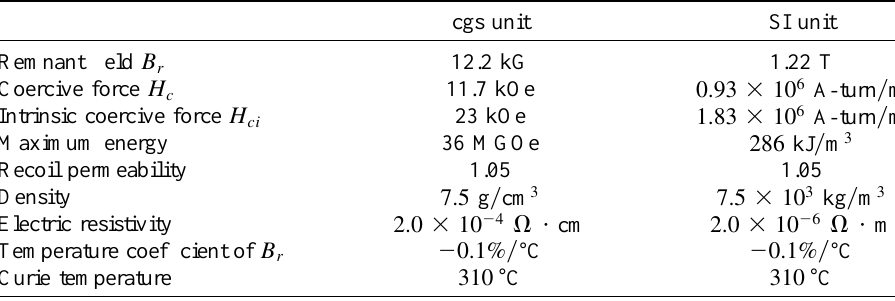
TABLE I. Typical characteristics of NdFeB 36